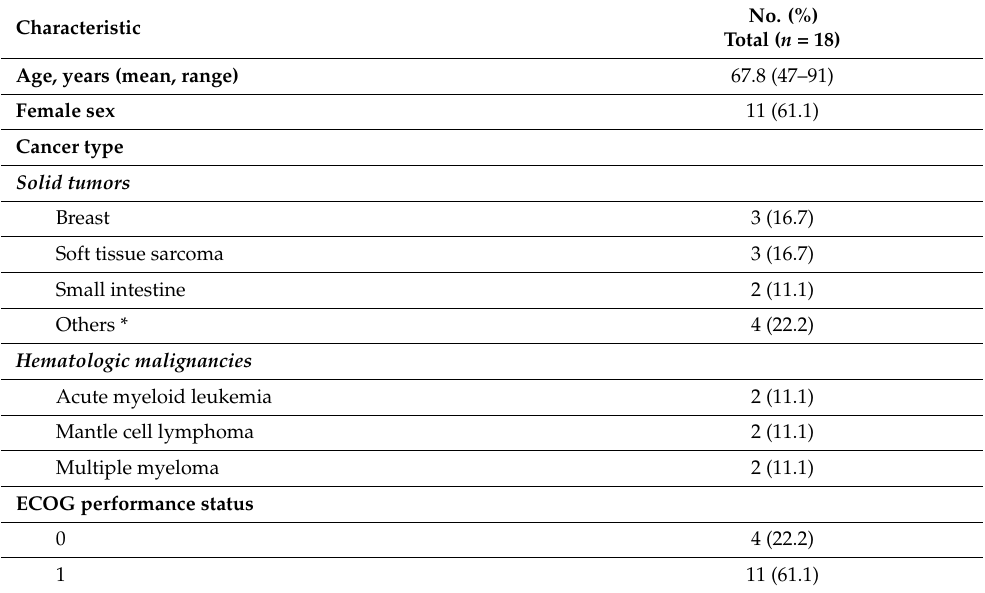
Figure 1. Flowchart for selection of the analyzed patients with OAT-related hospitalizations within the AMBORA trial. * Two patients were hospitalized twice within 12 weeks. Abbreviations: OAT, oral anticancer treatment. Table 1. Baseline characteristics of the analyzed patients with OAT-related hospitalizations within AMBORA.